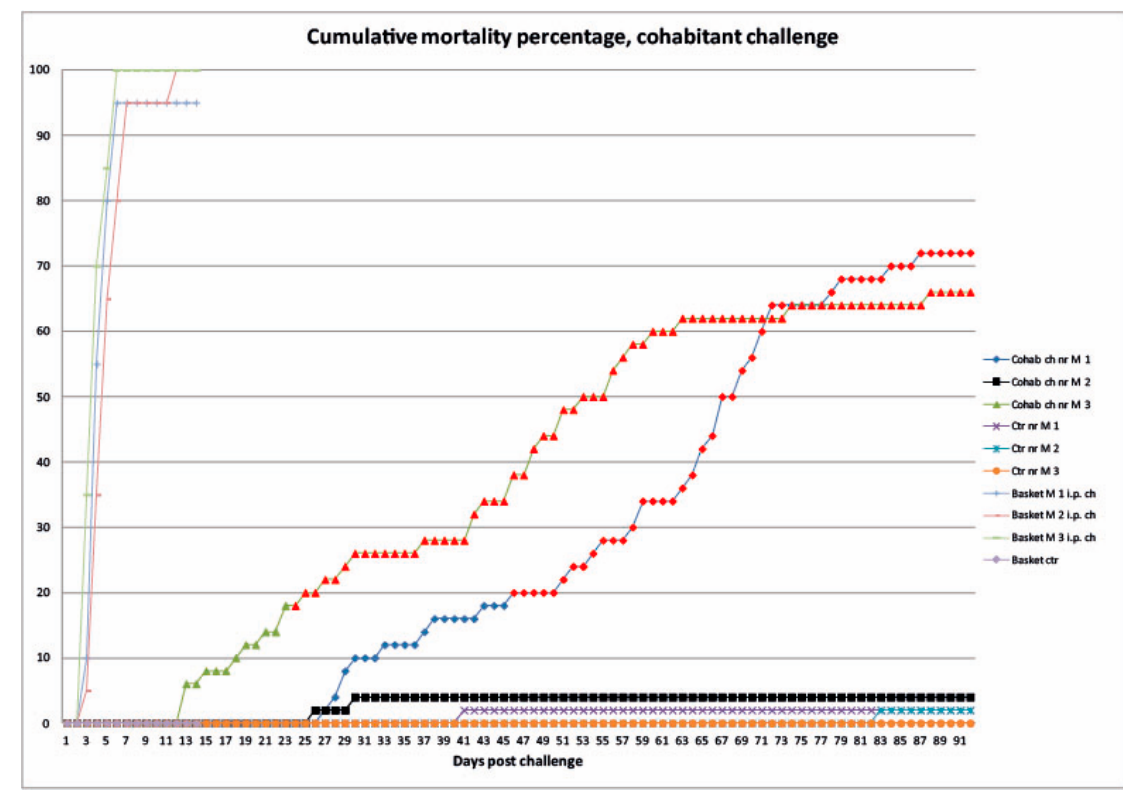
Figure 5. Cumulative mortality percentage of Atlantic cod ( Gadus morhua ) fish groups included in experiment 2; cohabitation challenge fish groups (Cohab ch nr) (n = 50 cohabitants in each tank); control fish groups (ctr nr) (n = 50 cohabitants in each tank); M = fish groups used for mortality registrations only. The challenged fish groups are juvenile cod, exposed to VHS isolate NO-2007-50-385, through cohabitation. Virus injected fish was kept in separate baskets within the fish tanks, referred to as “Basket M 1–3 i.p. ch” (n = 20 ip injected fish in each tank). Mortality data, from challenged fish, groups found significantly different from control groups are marked with a red colour ( p < 0.083, Bonferroni